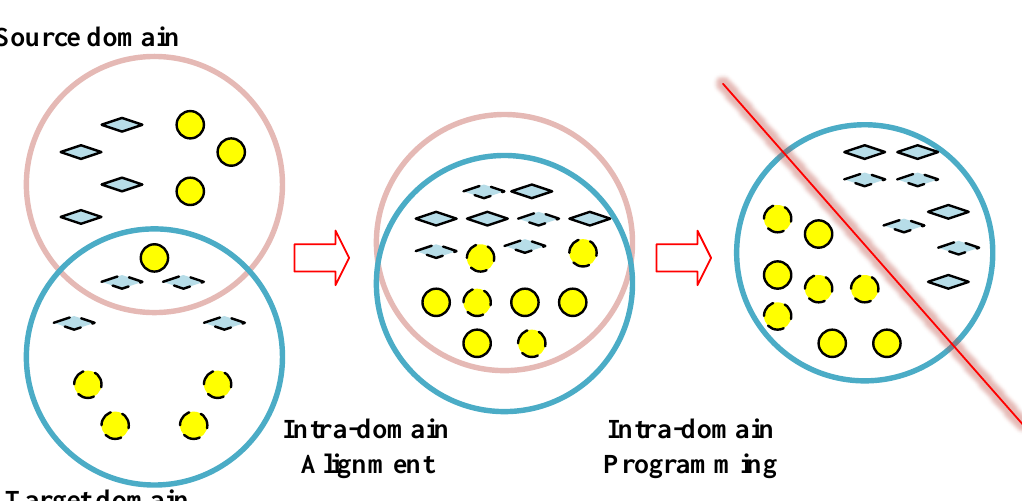
Figure 6. The procedure of EasyTL. The colored diamonds and circles denote samples from the source and target domain, respectively. The red line denotes the classifier.